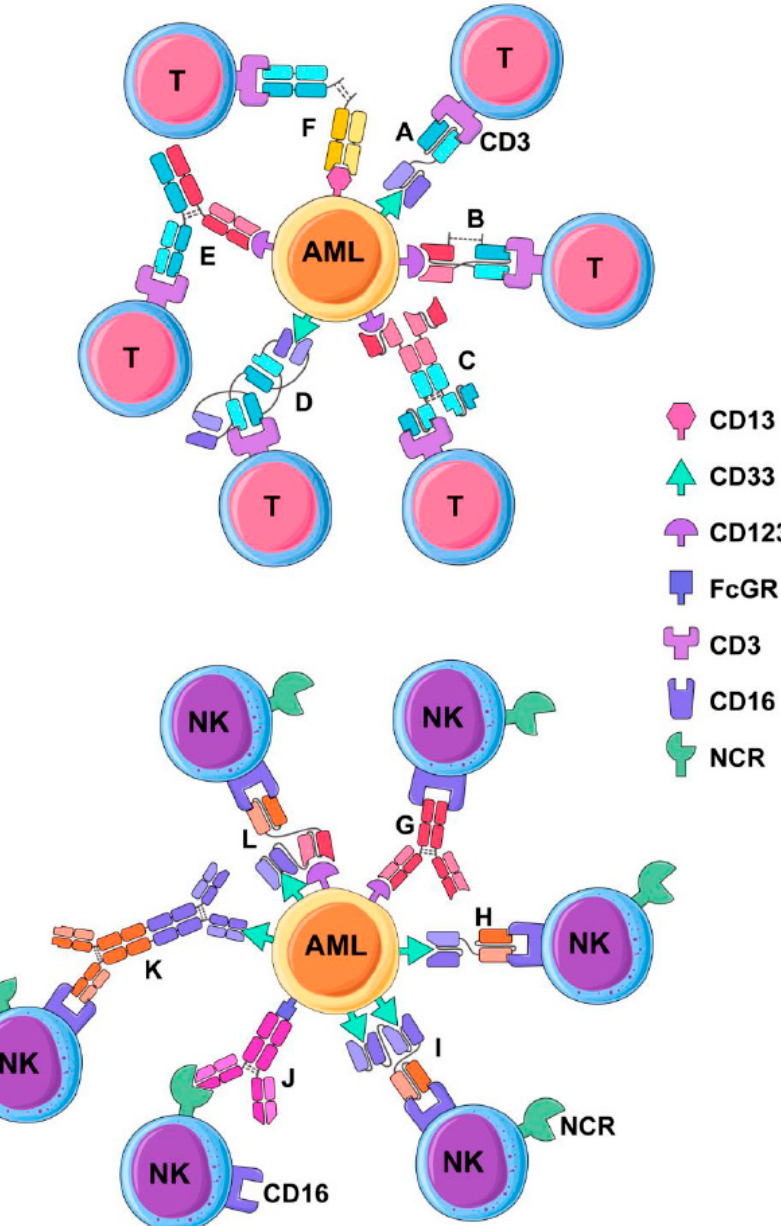
Figure 1. Antibody facilitated T and natural killer (NK) cell cytolysis of leukemia cells. T-cells and NK cells can be redirected to kill acute myeloid leukemia (AML) targets using a variety of antibody formats derived from the natively occurring IgG immunoglobulin molecule. Various approaches are diagrammed with key examples of each antibody format that has been developed. T-cell redirecting antibodies include ( A ) Bispecific tandem fragment variable format (BiTE, scBsTaFv), of which AMG 330 is an example (CD33 × CD3); ( B ) Dual Affinity Re-targeting Antibody (DART) (CD123 × CD3); ( C ) Bispecific single-chain Fv (scFv) immunofusion (Bif) (CD123 × CD3); ( D ) Bispecific tandem diabodies (TandAb) (AMV-564) (CD33 × CD3); ( E ) Duobody (CD123 × CD3); ( F ) Chemically conjugated Fab (CD3 × CD13). NK cell redirecting antibodies include ( G ) native IgG via antibody-dependent cell-mediated cytotoxicity (ADCC) (e.g., anti-CD123 mAb) CSL362); ( H ) Bi-specific Killer cell Engager (BiKE) (CD16 × CD33); ( I ) Tandem triple scfv (sctb); (CD33 × CD33 × CD16); (J ) native IgG via reverse-ADCC; antibody directed against a natural cytotoxicity receptor (e.g., anti-NKp30); ( K ) Chemically conjugated antibodies (CD16 × CD33); ( L) Tandem triple scfv (sctb); (CD33 × CD123 × CD16).